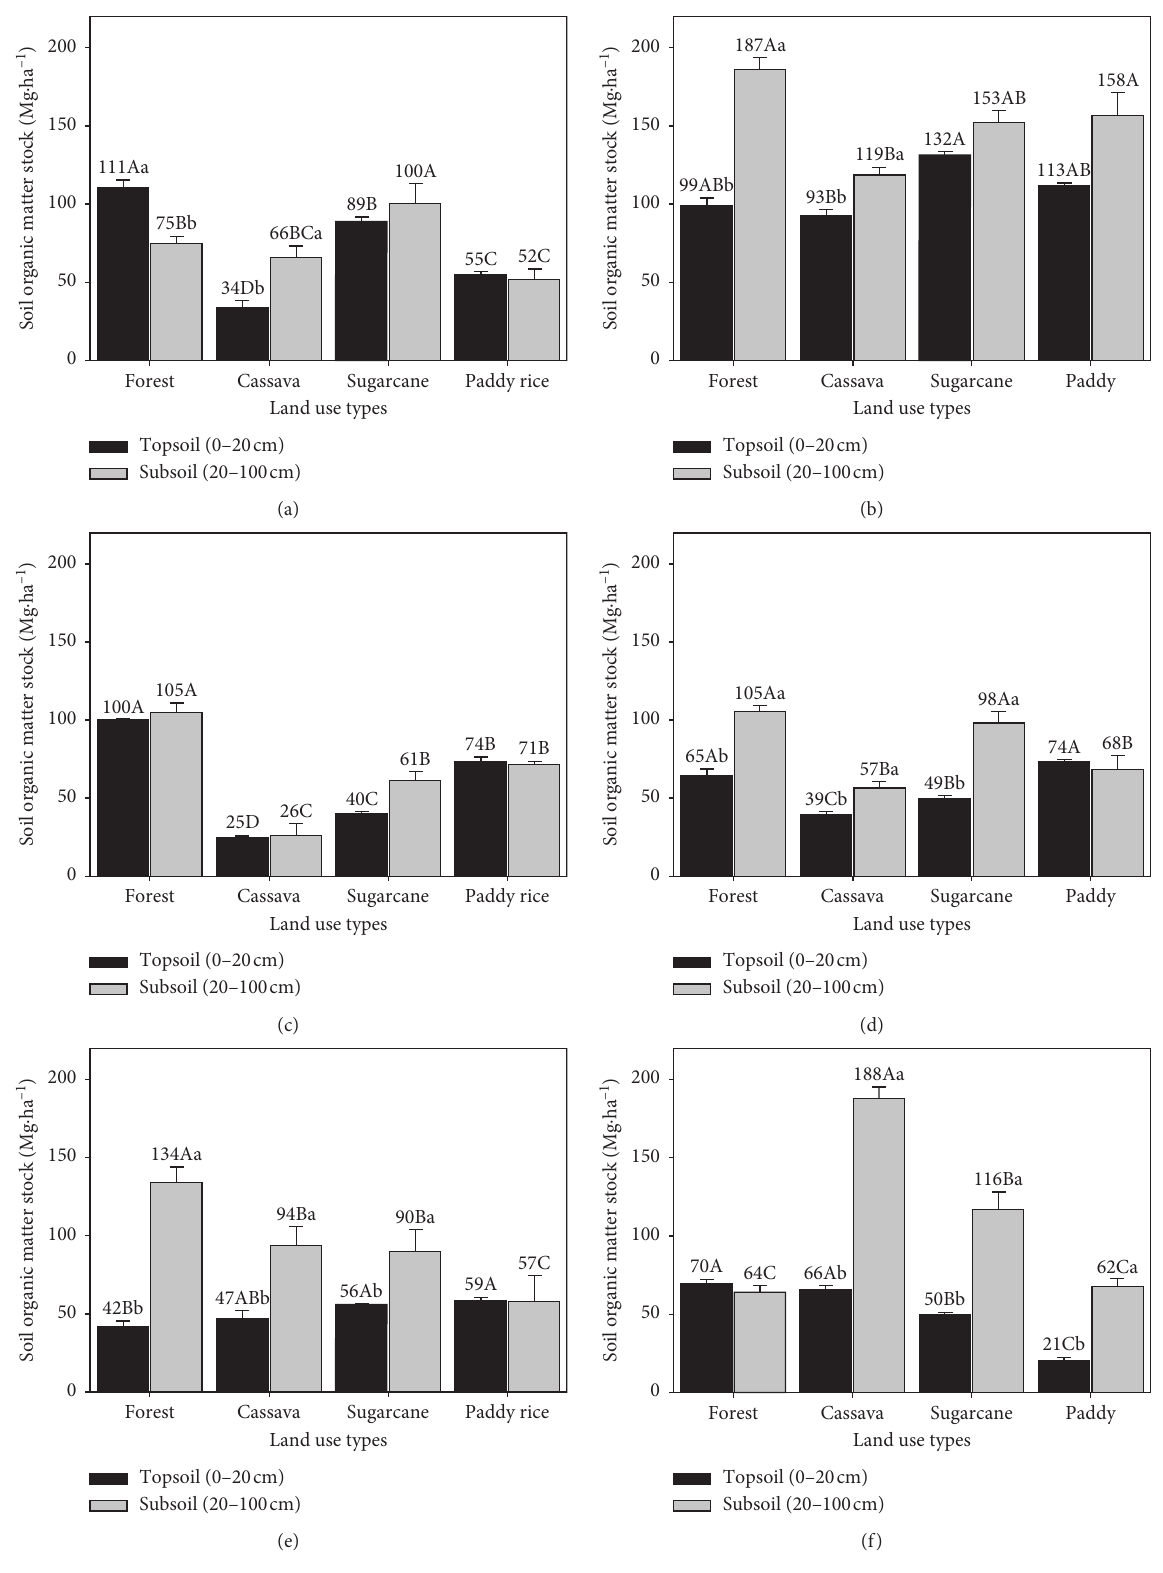
Figure 3: Land use changes affecting SOM stocks in topsoil (0–20cm) and subsoil (20–100cm) at six locations. Uppercase letters ac- companying bar graphs denote comparisons of SOM stocks of a topsoil or subsoil among different land uses. Lowercase letters denote comparison of SOM stocks between a top and subsoil within a land use type. Similar letters indicate no significant differences ( P > 0 . 05), as analysed by the LSD method. Error bars represent standard error of the mean. (a) Muang. (b) Kantharawichai. (c) Kosum Phisai. (d) Kut Rang. (e) Borabue. (f) Wapi